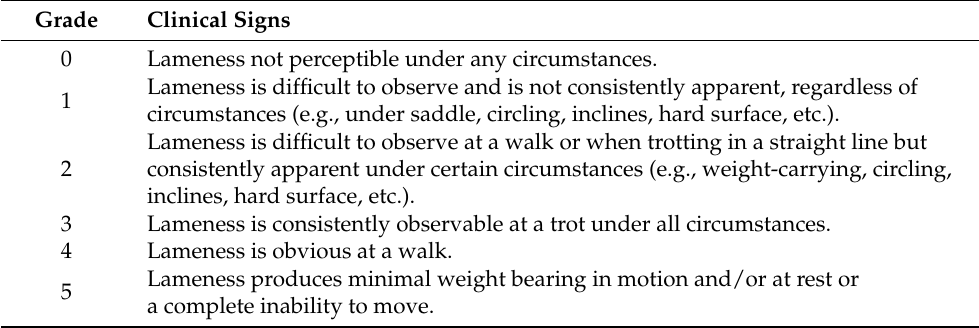
Table 1. American Association of Equine Practitioners Lameness Scale